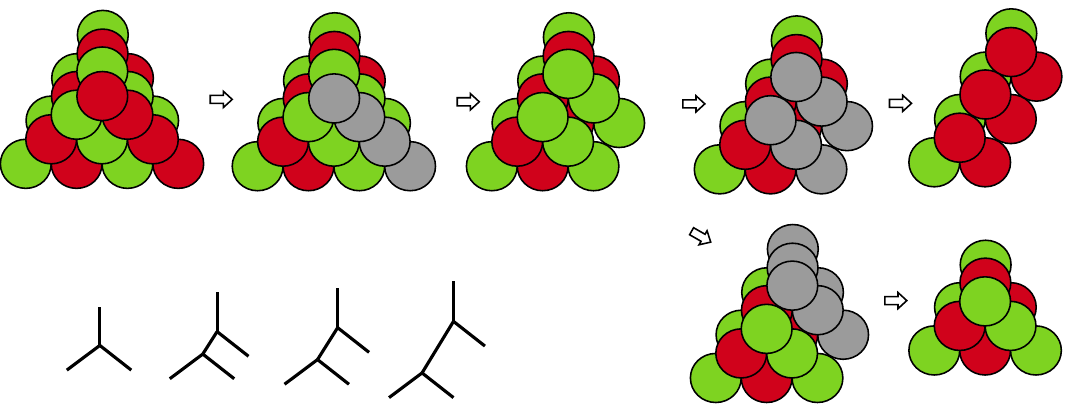
Figure 12 . Peeling off the semi-infinite faces of the C × C 2 / Z 2